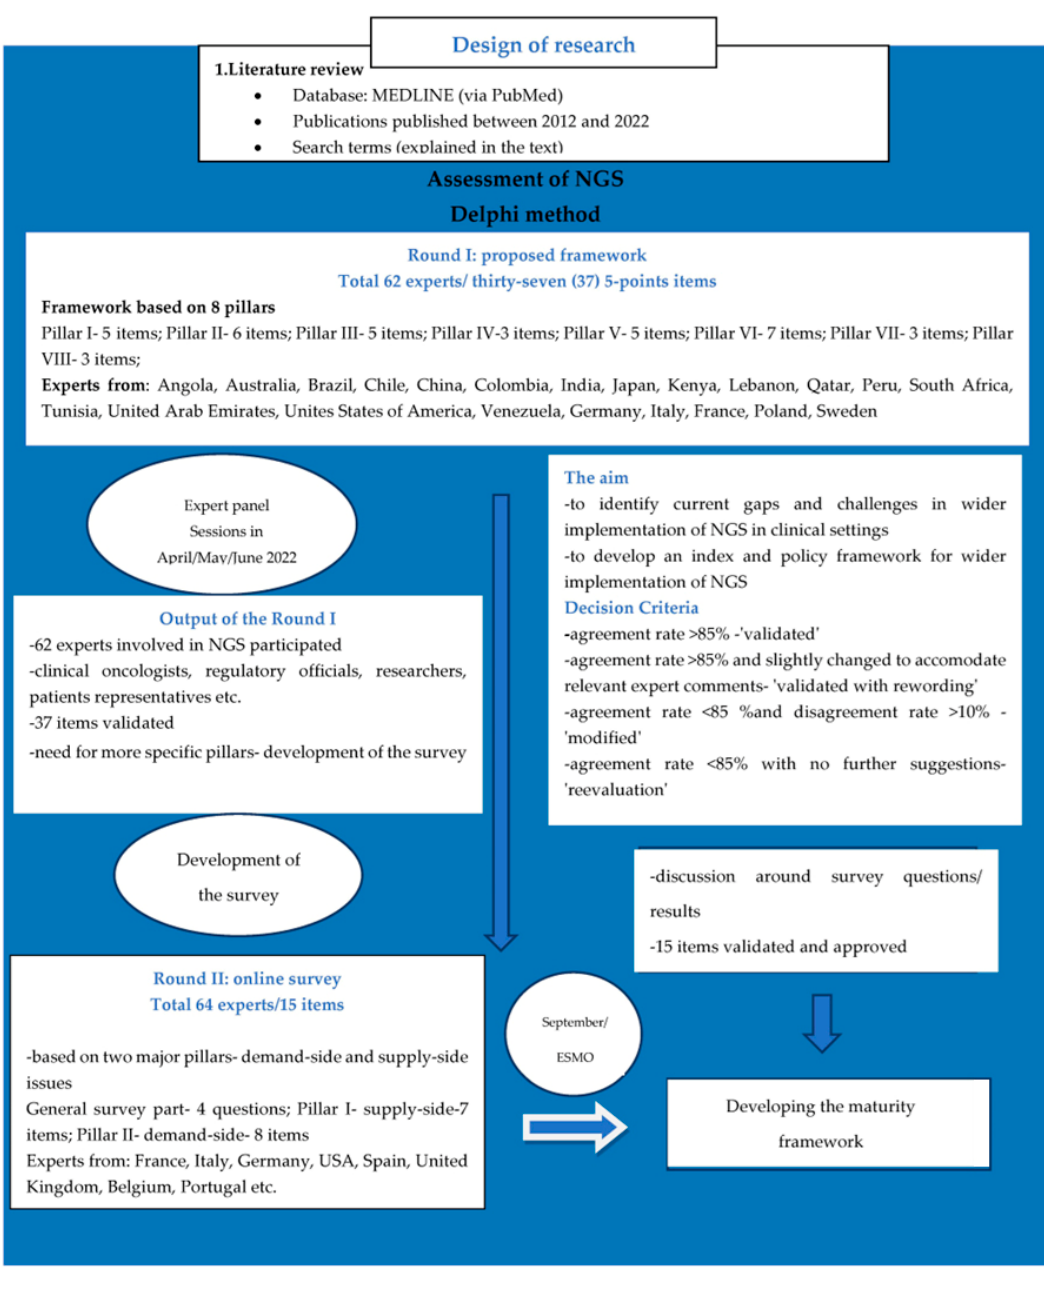
Figure 1. The methodology used to develop a maturity framework to tackle the implementation gap for implementation of NGS on the global level.